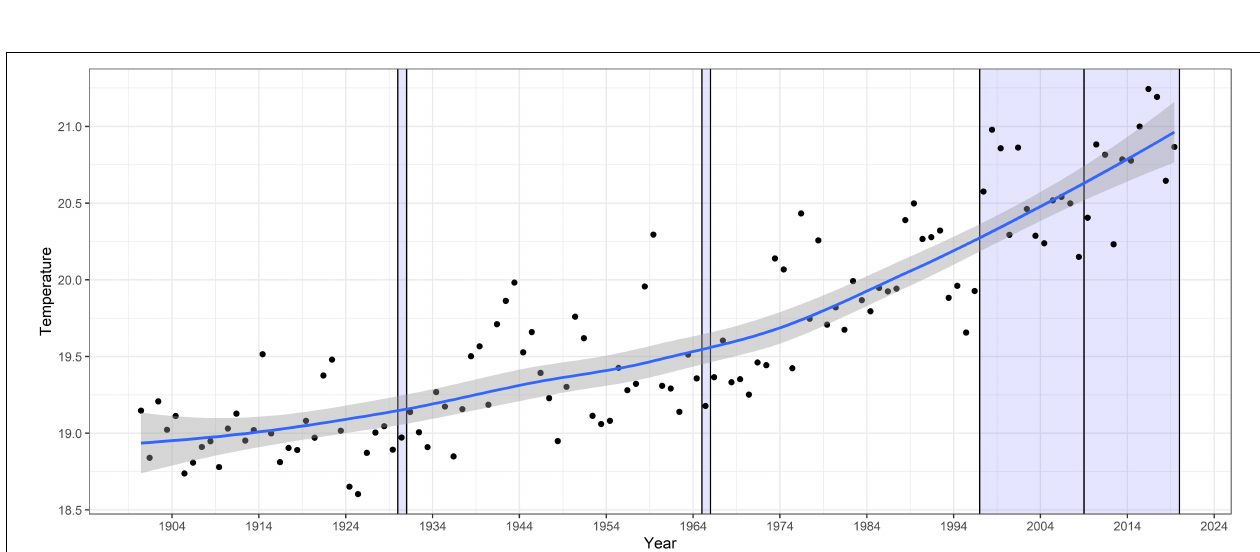
FIGURE 3 | Annual mean and 95% confidence levels of long-term temperature at PH 100m from Hadley SST with phytoplankton surveys marked by lines and shaded regions.